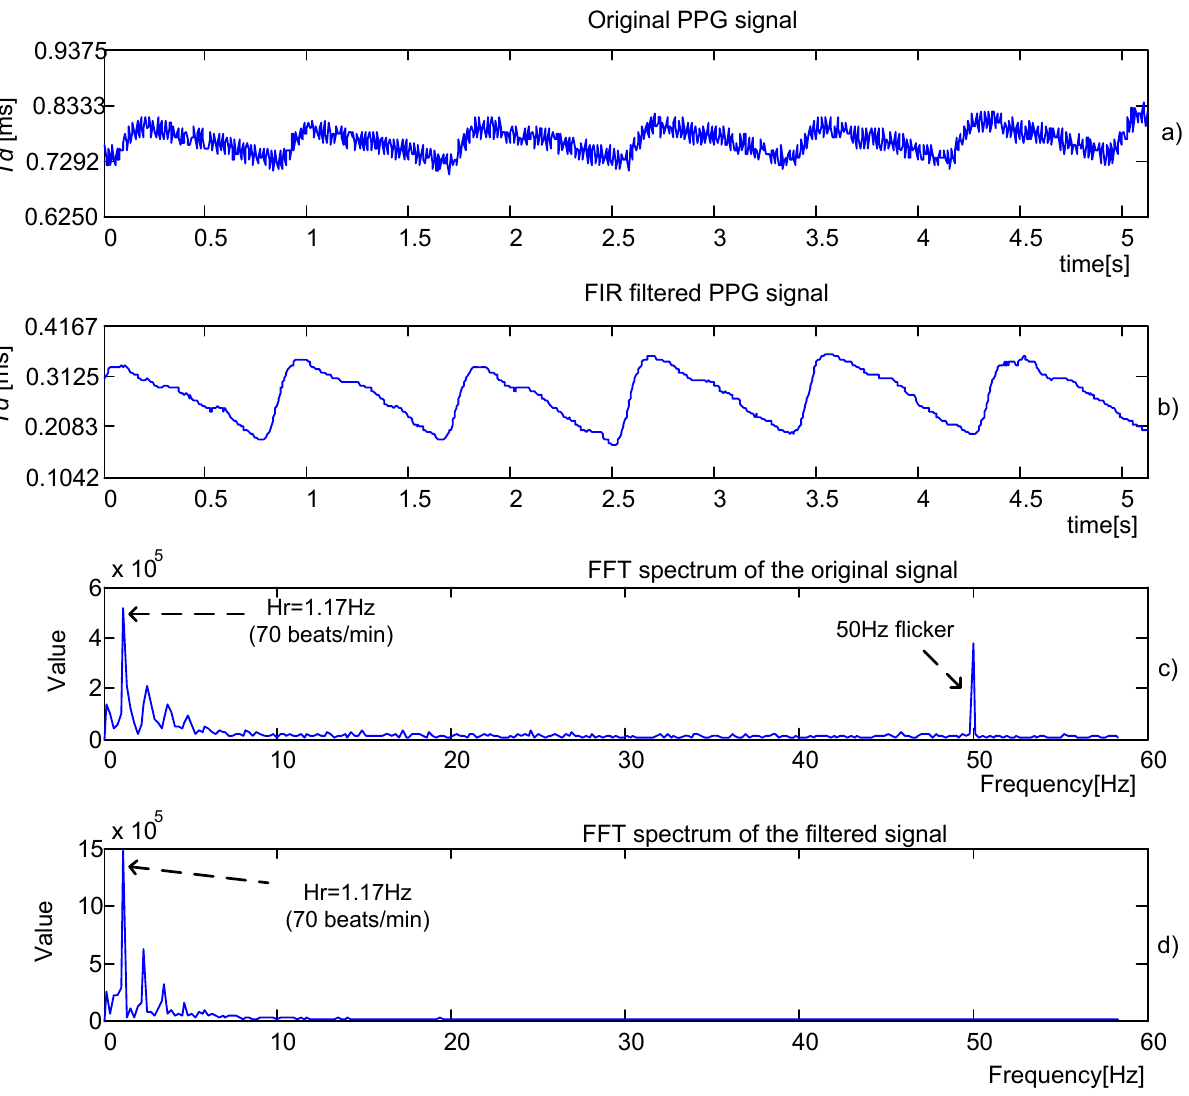
= 200 Hz, f = 10 Hz. sl c